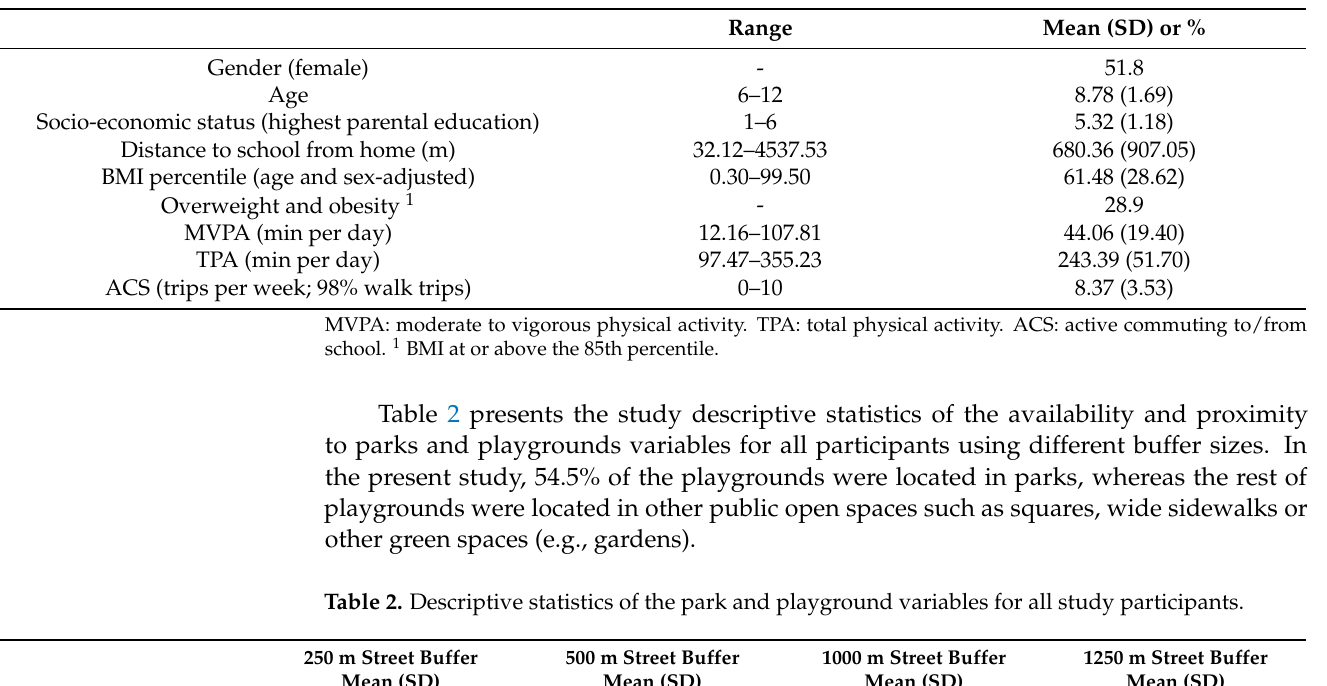
Table 1. Descriptive statistics of the sample.